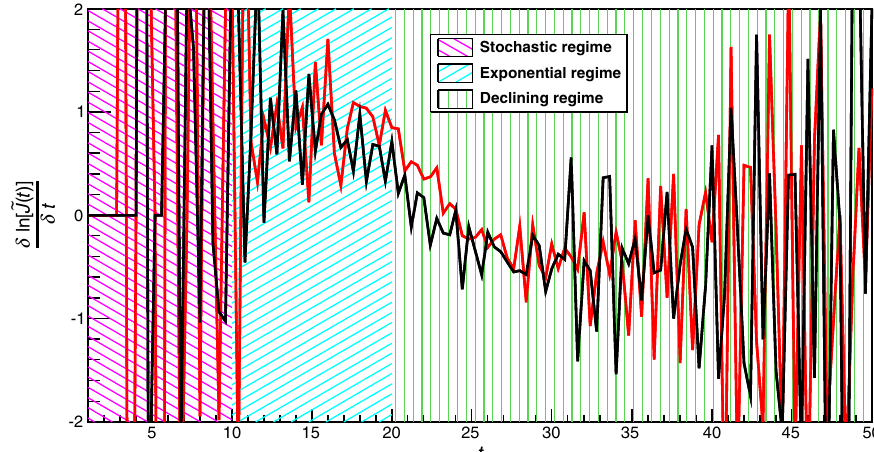
FIG. 2. Two hypothetical realizations of an epidemic process on a network. The left, middle, and right sections represent stochastic, exponential, and declining regimes,